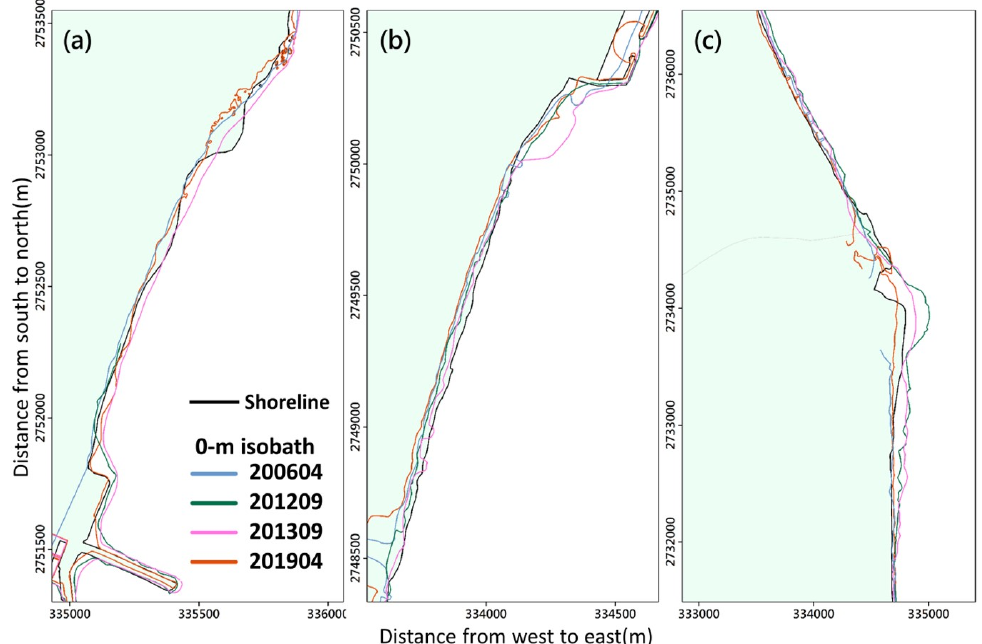
Figure 3. Evolution of the 0 m isobath along ( a ) the northern Wushi Fishery Port, ( b ) the southern Wushi Fishery Port, and ( c ) the Lanyang River estuary.